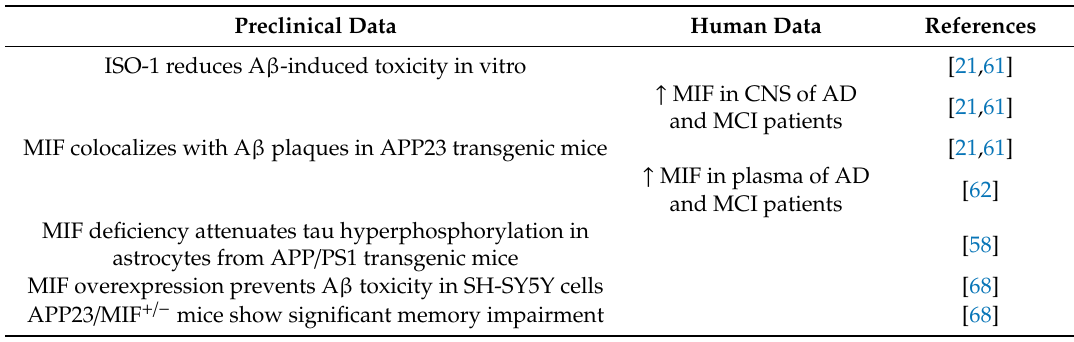
Table 2. Evidences for the involvement of the Macrophage Migration Inhibitory Factor (MIF) in Alzheimer (cid:48) s Disease